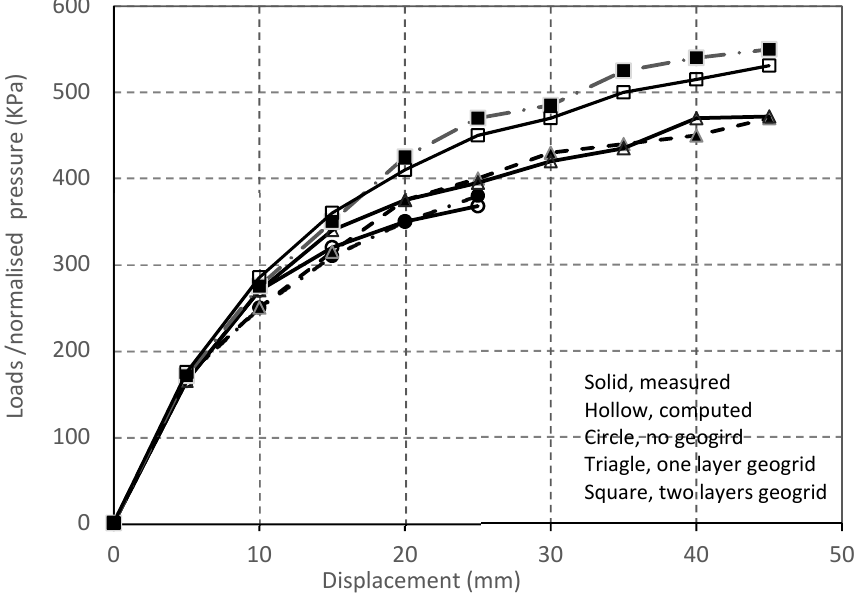
Figure 2. Comparison of computed load–displacement curves with the measured results in [6].